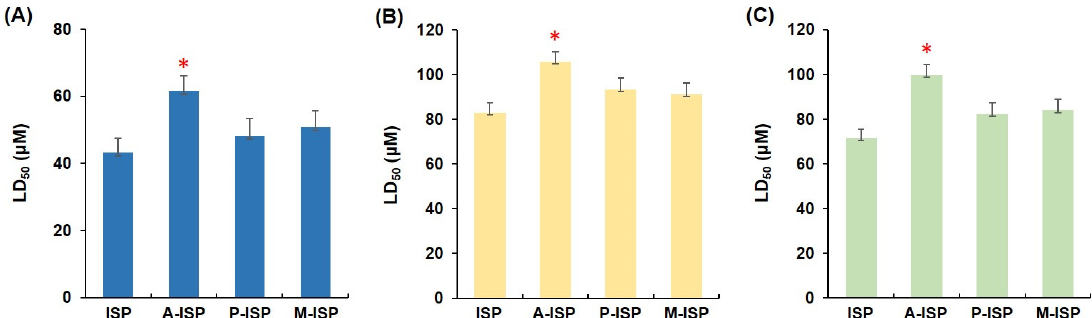
Figure 3. Cytotoxicity of newly synthesized ISP analogs against three different mammalian renal cell lines. LD 50 ( µ M) of ISP analogs against ( A ) HEK-293, ( B ) LLC-PK1, and ( C ) A-498 cells. Data are expressed as means ( n = 3) ± standard deviations and tested for significance using the paired or unpaired two-tailed t -test with analysis of variance as appropriate. n indicates biologically independent experiments. Results with * p < 0.05 were considered significant.